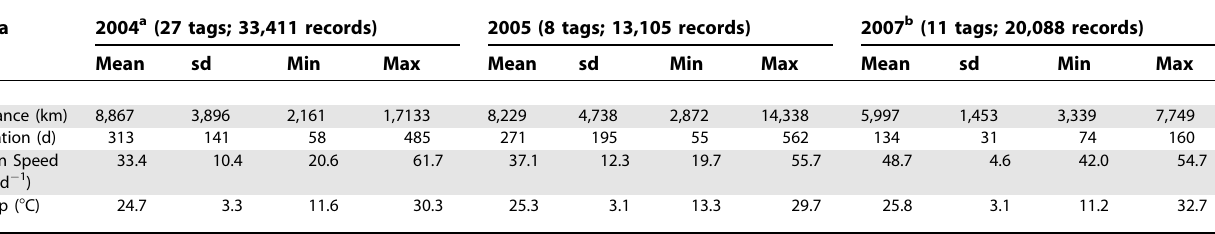
Table 1. Tracking Data from 46 Satellite-Linked Tags Deployed on Leatherback Turtles on Playa Grande, Costa Rica, 2004–-2007